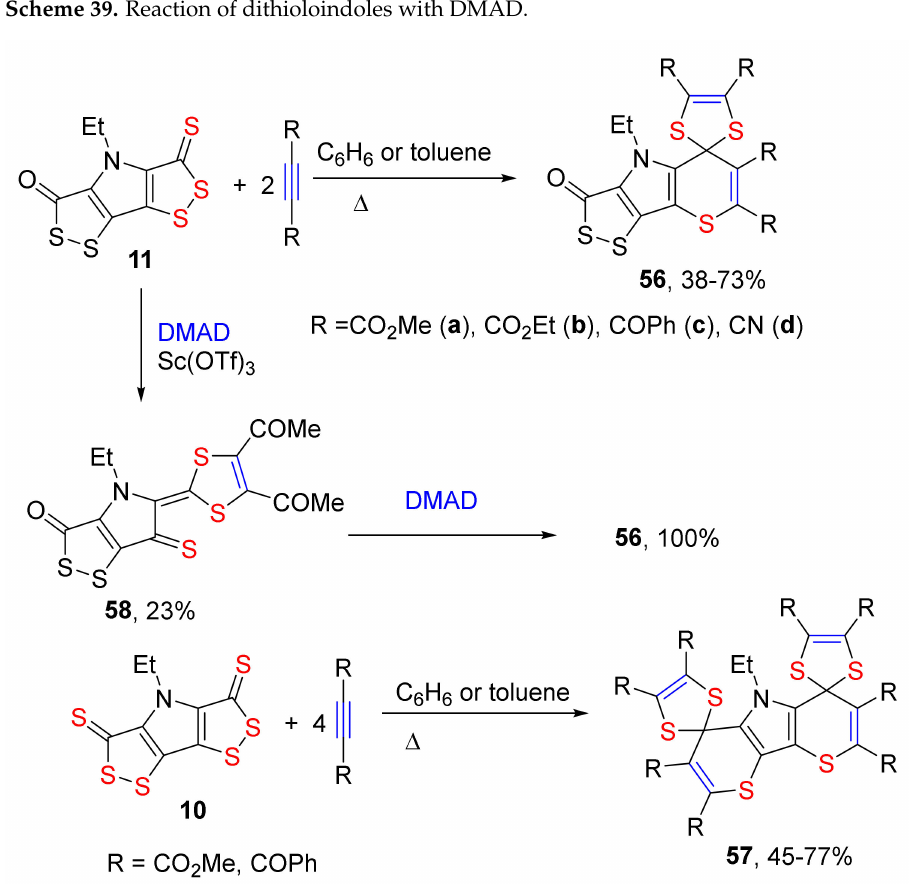
Scheme 39. Reaction of dithioloindoles with